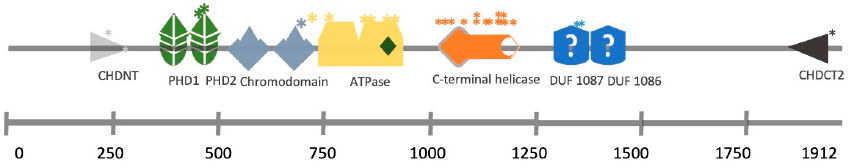
Figure 2. CHD4 structural domains and the location of SNPs identified in a cohort of SIHIWES patients. * Mutation